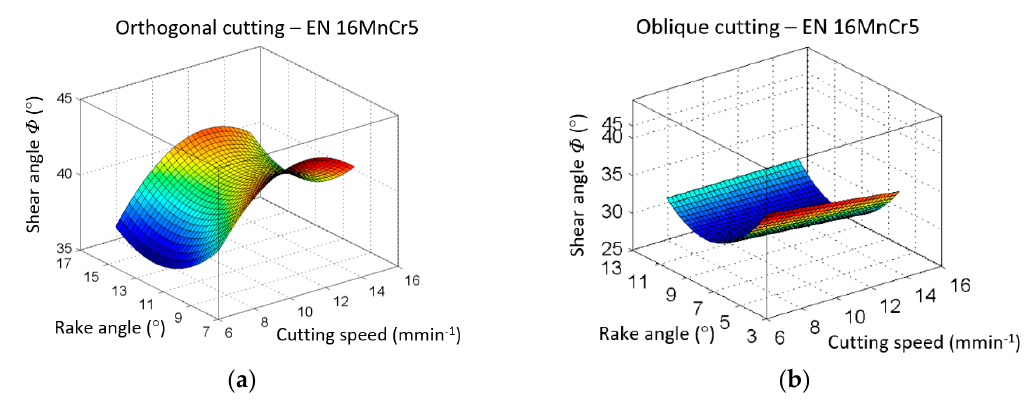
Figure 21. Dependence of shear angle Φ on cutting speed v c and rake γ ; ( a ) orthogonal cutting; ( b ) oblique cutting.